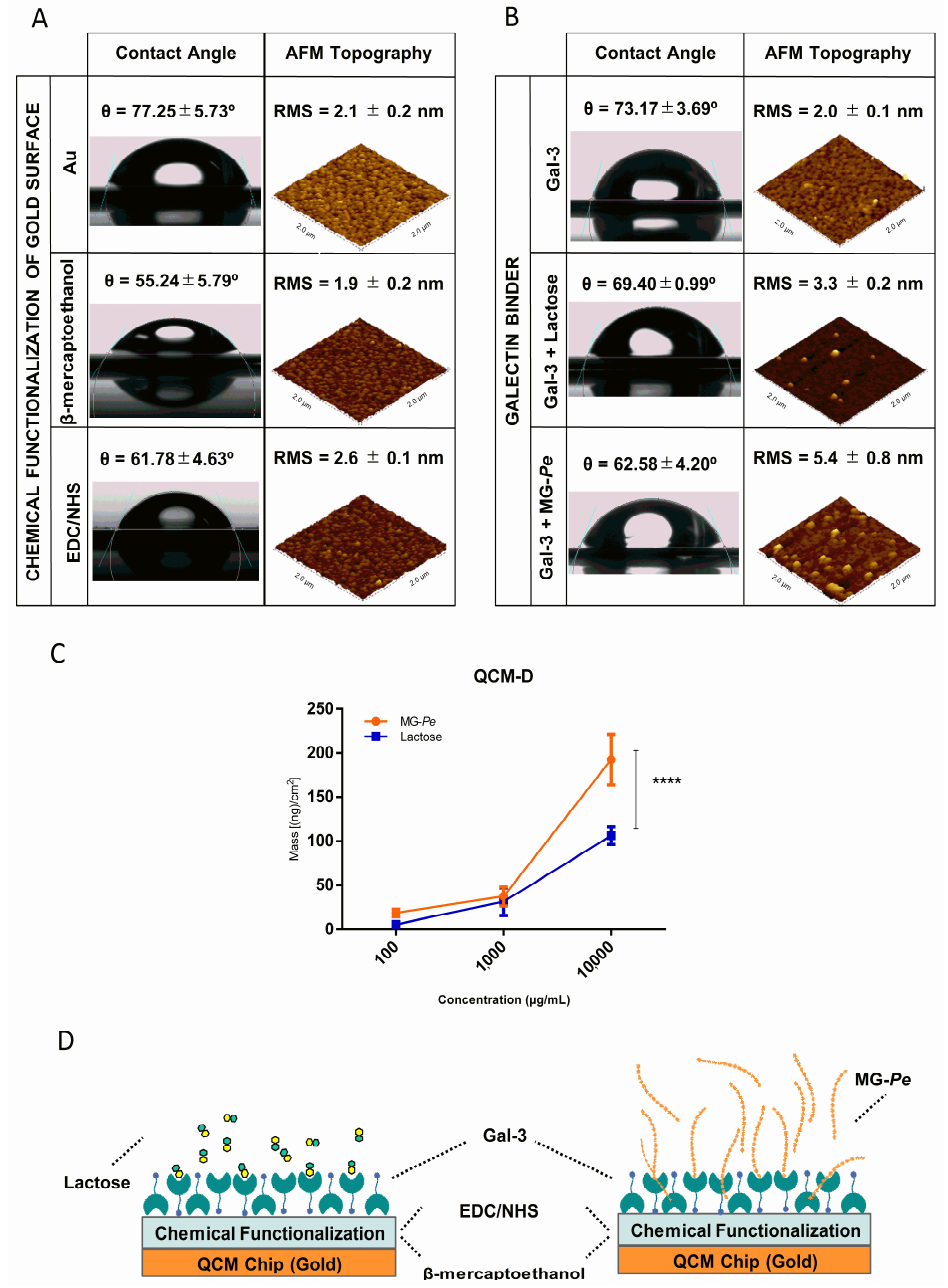
Figure 3. MG- Pe is a Gal-3 Binder. ( A ) Chemical functionalization of gold surface; ( B ) Gal-3 and its ligands—contact angle and AFM (atomic force microscopy) (2.0 × 2.0 µm scale); ( C ) QCM-D (quartz crystal microbalance with dissipation monitoring) . Analyzed by two-way ANOVA test with Sidak with multiple comparisons; **** p ≤ 0.0001; and ( D ) schematic representation of a QCM-D crystal surface.